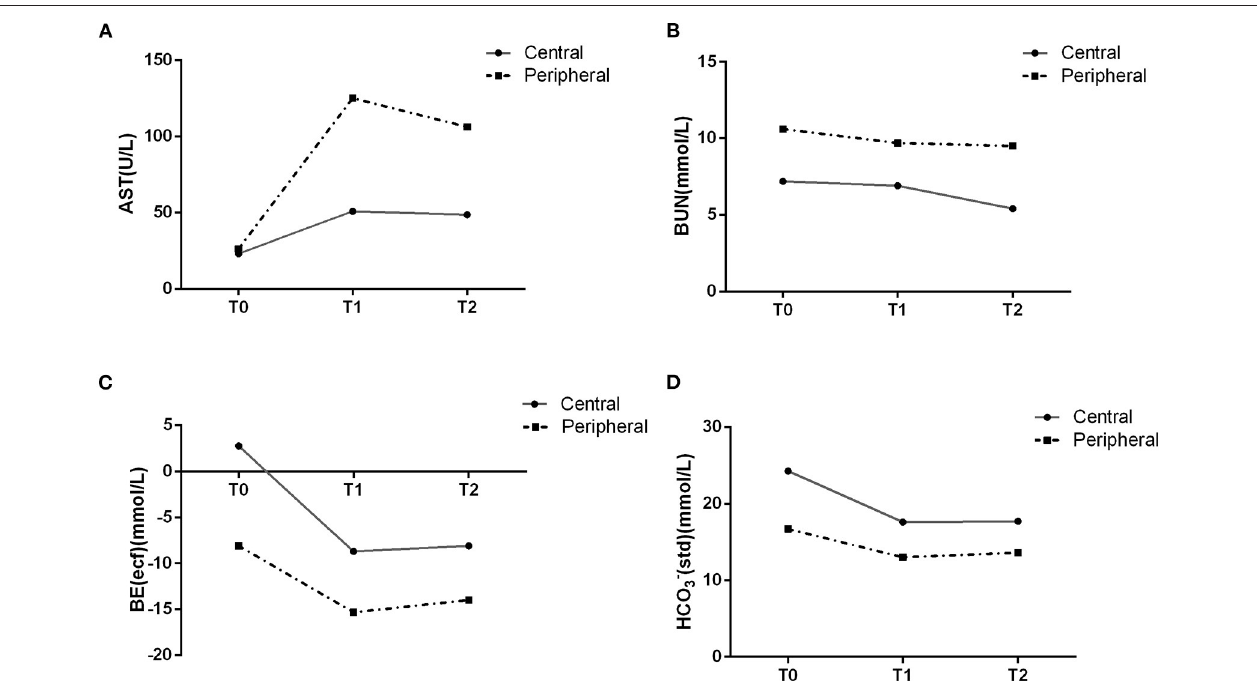
FIGURE 3 | AST and BUN levels in the blood suggested an effect of peripheral cannulation on organ perfusion (A,B) . Changes in gas analysis are shown for the two cannulation groups (C,D) .